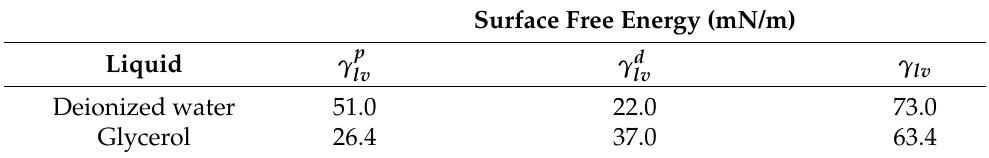
Table 3. Polar, dispersive, and total surface free energies of the probe liquids employed for contact angle